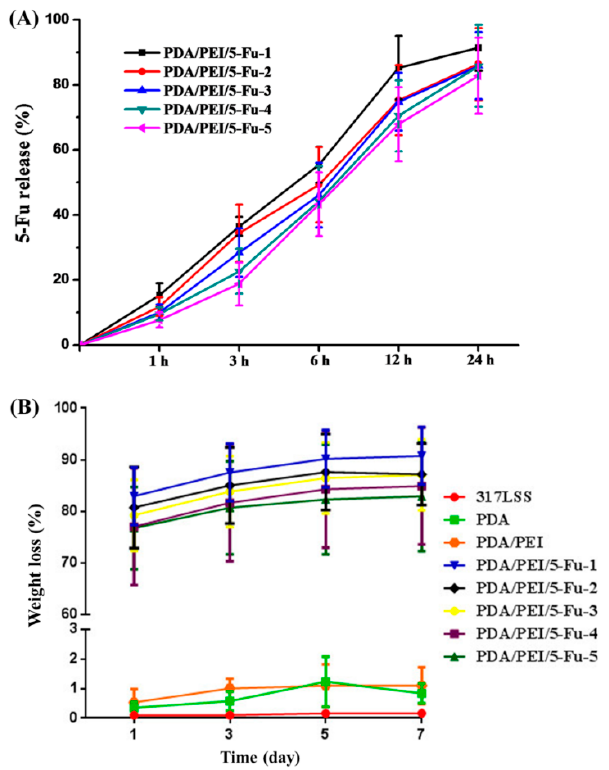
Figure 4. ( A ) 5-Fu release from the PDA/PEI/5-Fu-1, PDA/PEI/5-Fu-2, PDA/PEI/5-Fu-3, PDA/PEI/5-Fu-4 and PDA/PEI/5-Fu-5 surfaces within 24 h (mean ± SD, n = 5); ( B ) Weight loss of the PDA/PEI/5-Fu-1, PDA/PEI/5-Fu-2, PDA/PEI/5-Fu-3, PDA/PEI/5-Fu-4, PDA/PEI/5-Fu-5, PDA/PEI, PDA and 317L SS samples after immersed in the PBS for 1 day, 3 days, 5 days and 7 days